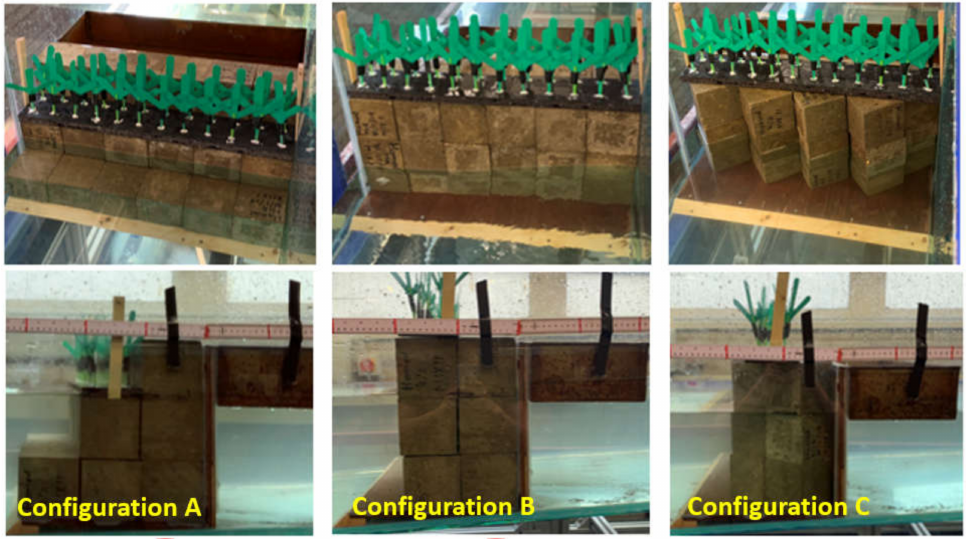
Figure 3. Overall geometrical